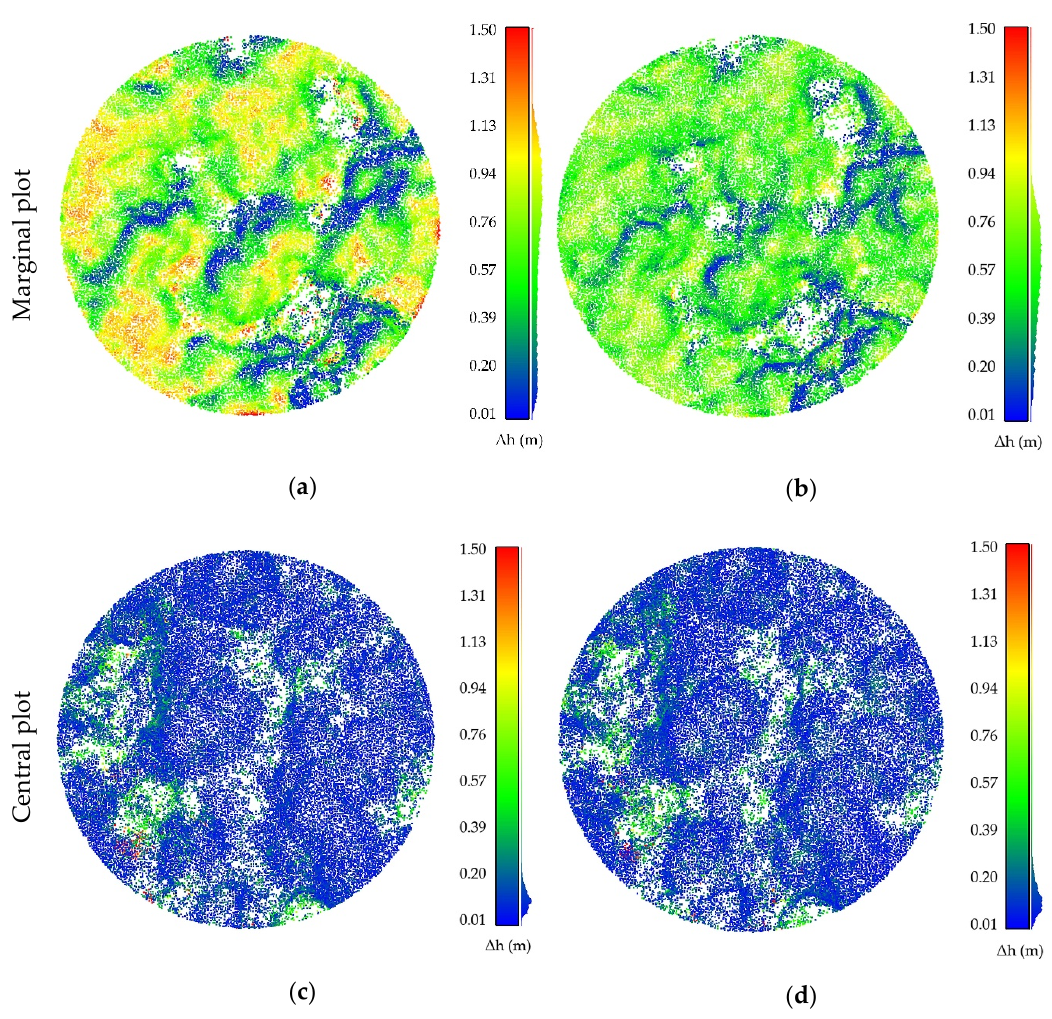
Figure 4. Vertical differences (∆h) between: (a) InSO and GNSS-SO 2 PCs for marginal plot; (b) GNSS- Figure4. Verticaldi ff erences( ∆ h)between: ( a )InSOandGNSS-SO 2 PCsformarginalplot; ( b )GNSS-SO 1 SO 1 and GNSS-SO 2 PCs for marginal plot; (c) InSO and GNSS-SO 2 PCs for central plot; (d) GNSS-SO 1 and GNSS-SO 2 PCs for marginal plot; ( c ) InSO and GNSS-SO 2 PCs for central plot; ( d ) GNSS-SO 1 and and GNSS-SO 2 PCs for central plot. GNSS-SO 2 PCs for central